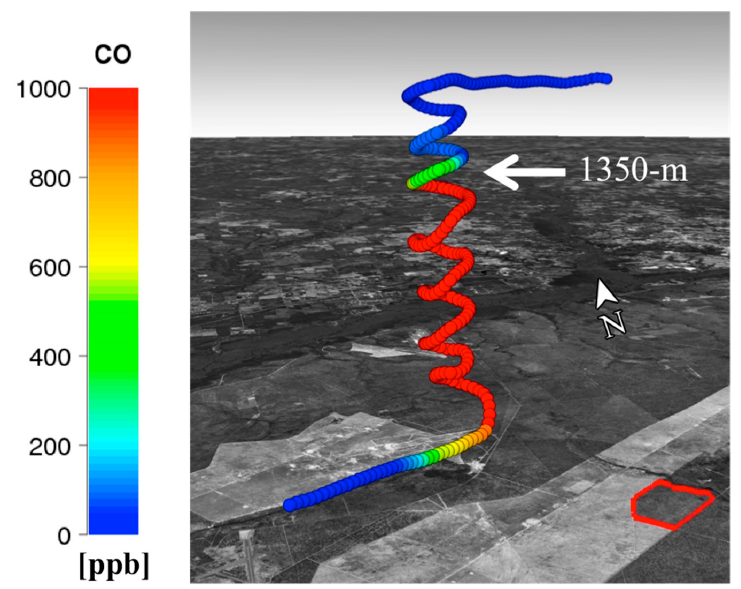
Figure 12. Same as Figure 10, but for the corkscrew vertical profile at 1830–1835 UTC. Map data: Google, DigitalGlobe.